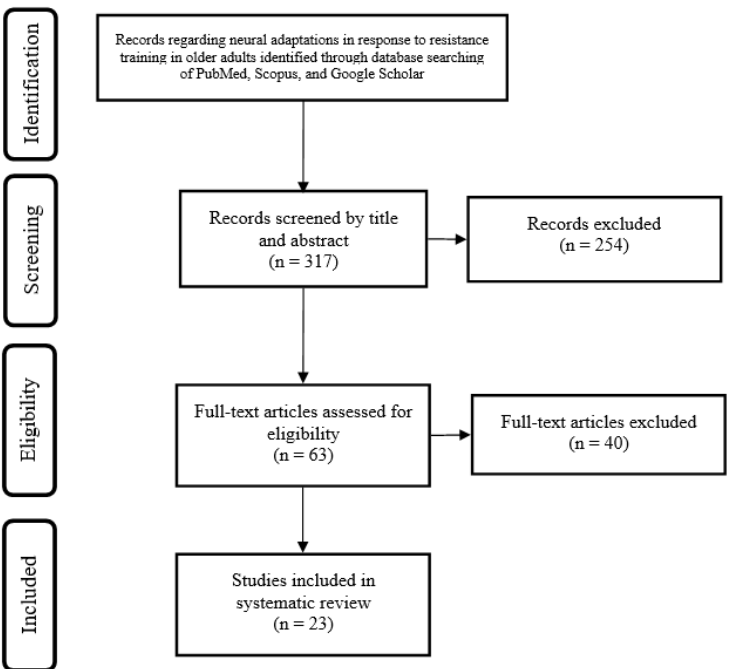
Figure 1. Flow-chart illustration of the literature search .